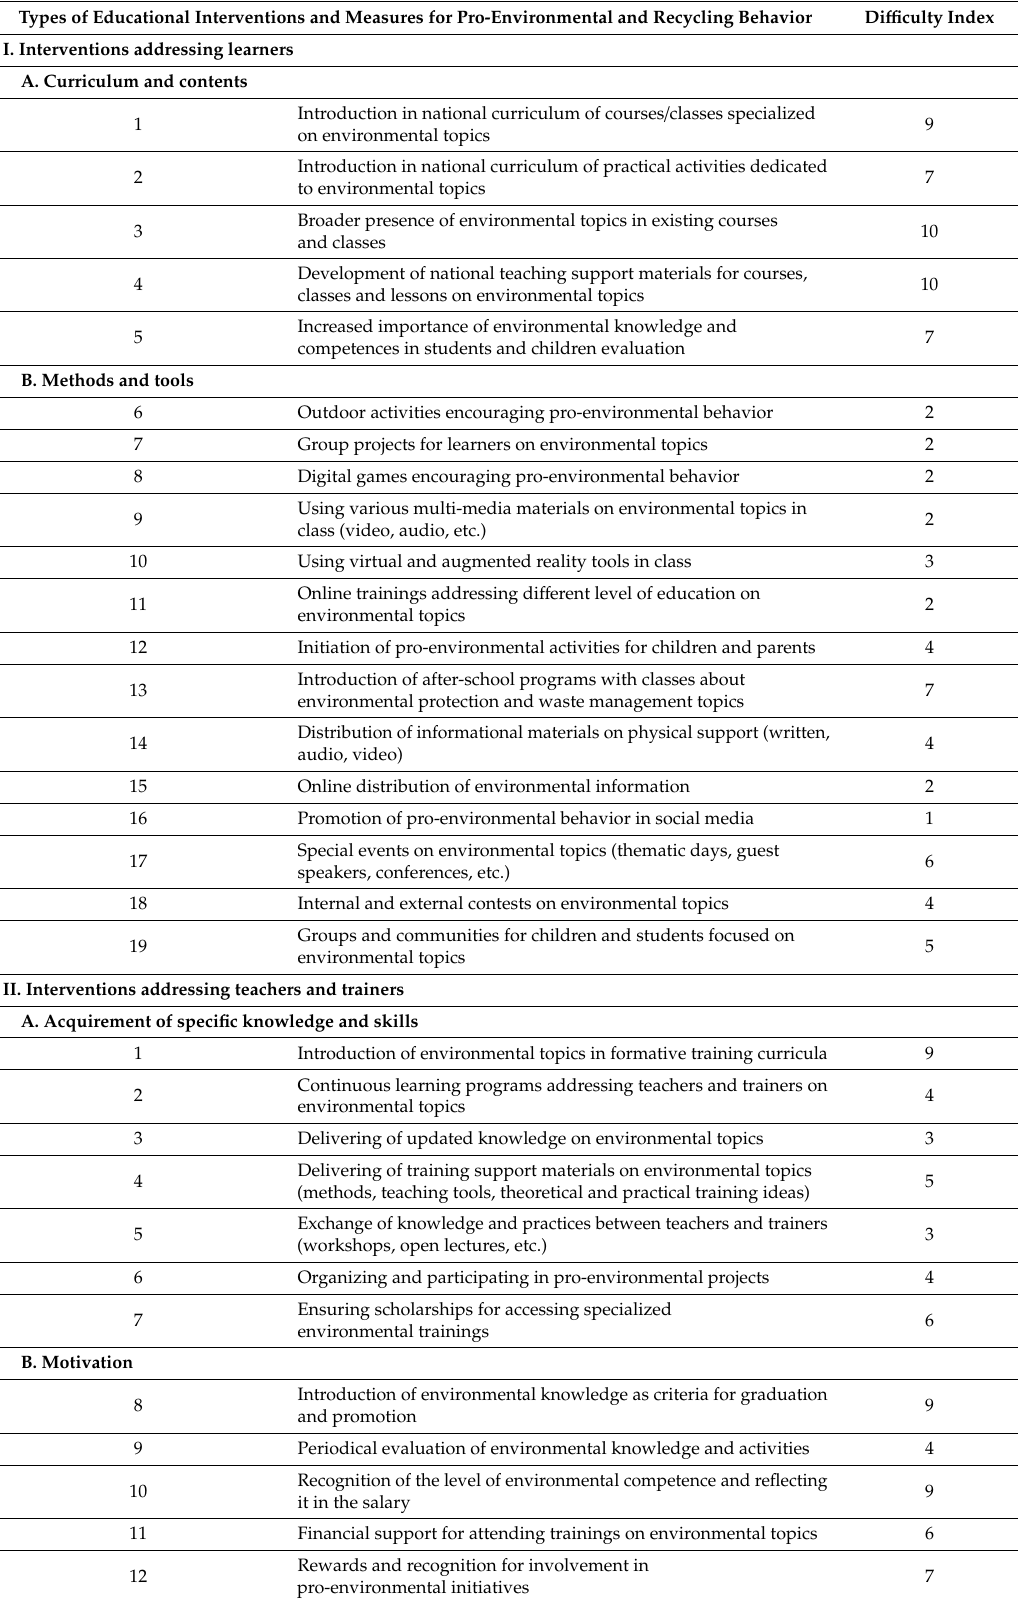
Table 5. Types of educational interventions and measures for pro-environmental and recycling behavior. Types of Educational Interventions and Measures for Pro-Environmental and Recycling Behavior Di ffi culty